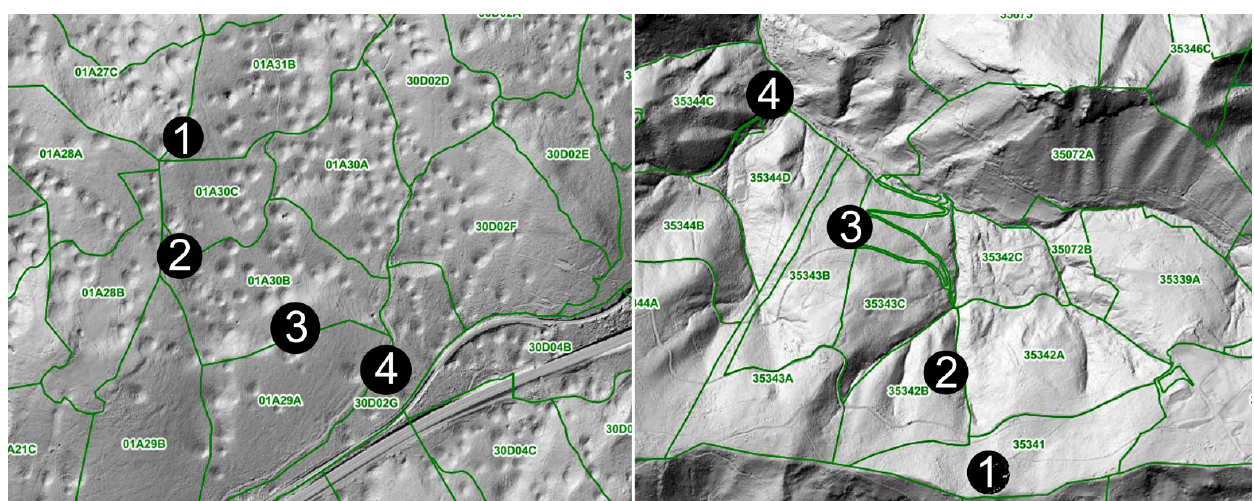
Figure 2. Location of micrometeorological stations, arranged from the locally highest (1) to the lowest (4) elevation at the Postojna ( left ) and Celje ( right ) research sites (M = 1:1000; source: Slovenia Forest Service).